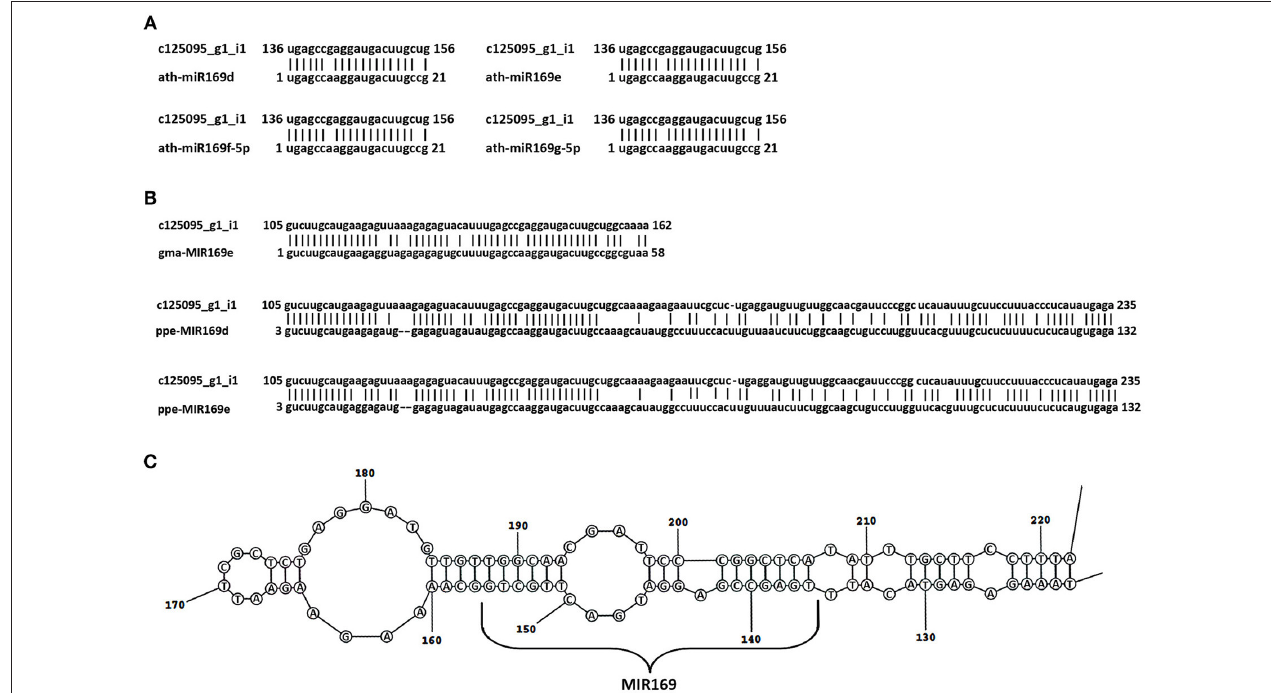
FIGURE 5 | Identification of the Lupinus luteus miR169e precursor. Alignment of the nucleotide sequence of the c125095g1_i1 unigene with mature miR169d, -e, -f, and -g from A . thaliana (A) and the miR169 precursors from other plant species shows the highest homology (B) . miRBase Accession Nos from top to bottom: MIMAT0000908, MIMAT0000909, MIMAT0000910, MIMAT0000911, MI0016576, MI0026086, MI0021629. (C) Secondary stem-loop structures of the pre-miR169e of yellow lupine. Localization of mature miR169 is shown on the stem of the precursor